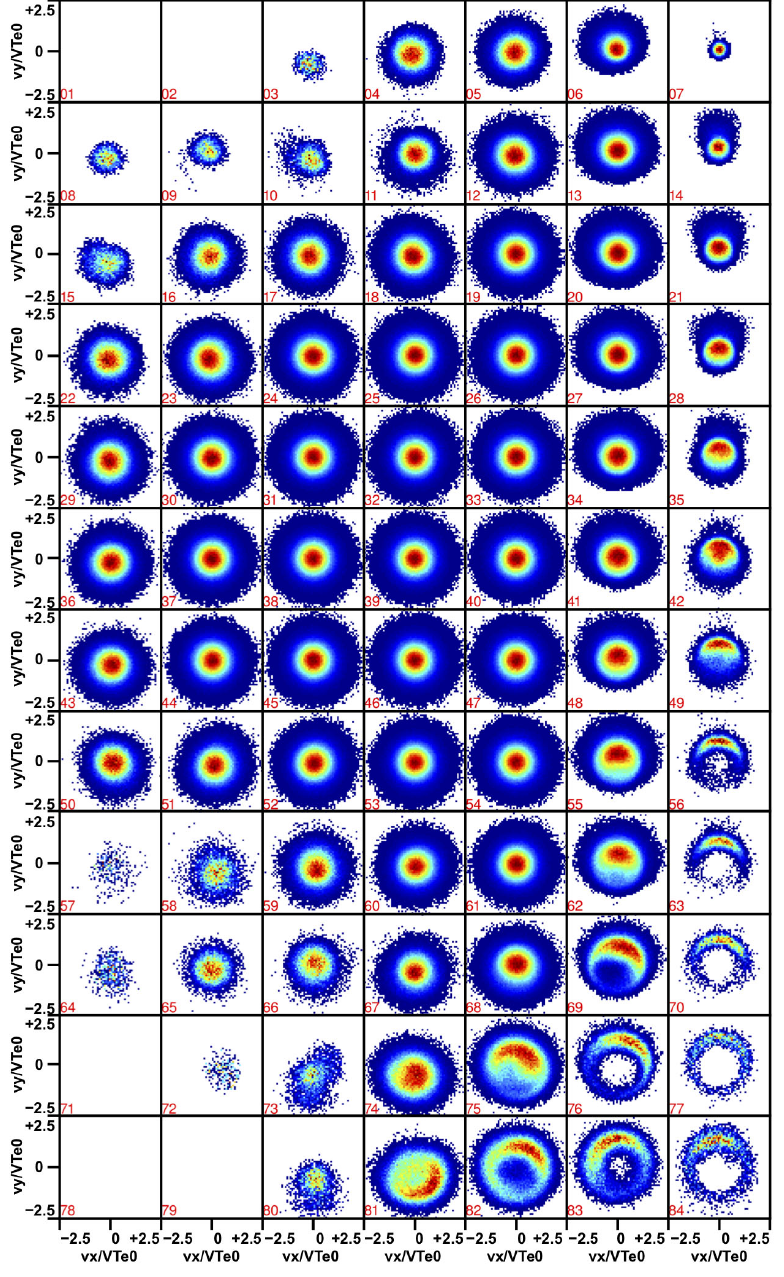
Figure A3. Electron VDFs, at t = 1 . 9 T Li , for each of the 84 spatial bins defined in Fig. A1b. We show v z = 0 cross sections. The nine VDFs presented in Fig. 3 of the article correspond to bins 39, 6, 13, 41, 69, 76, 83, 75 and